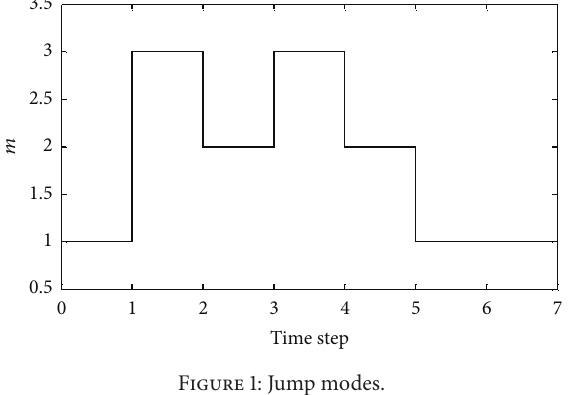
Figure 1: Jump modes.